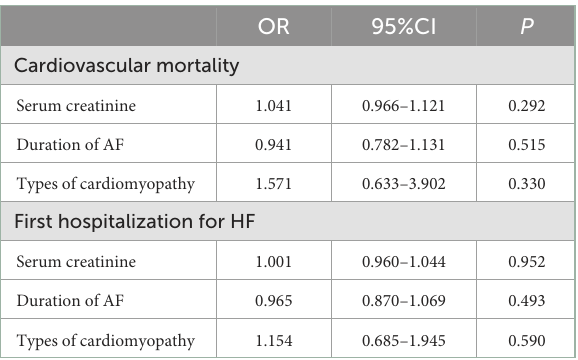
TABLE 4 Logistic regression analysis for cardiovascular mortality and the first hospitalization for